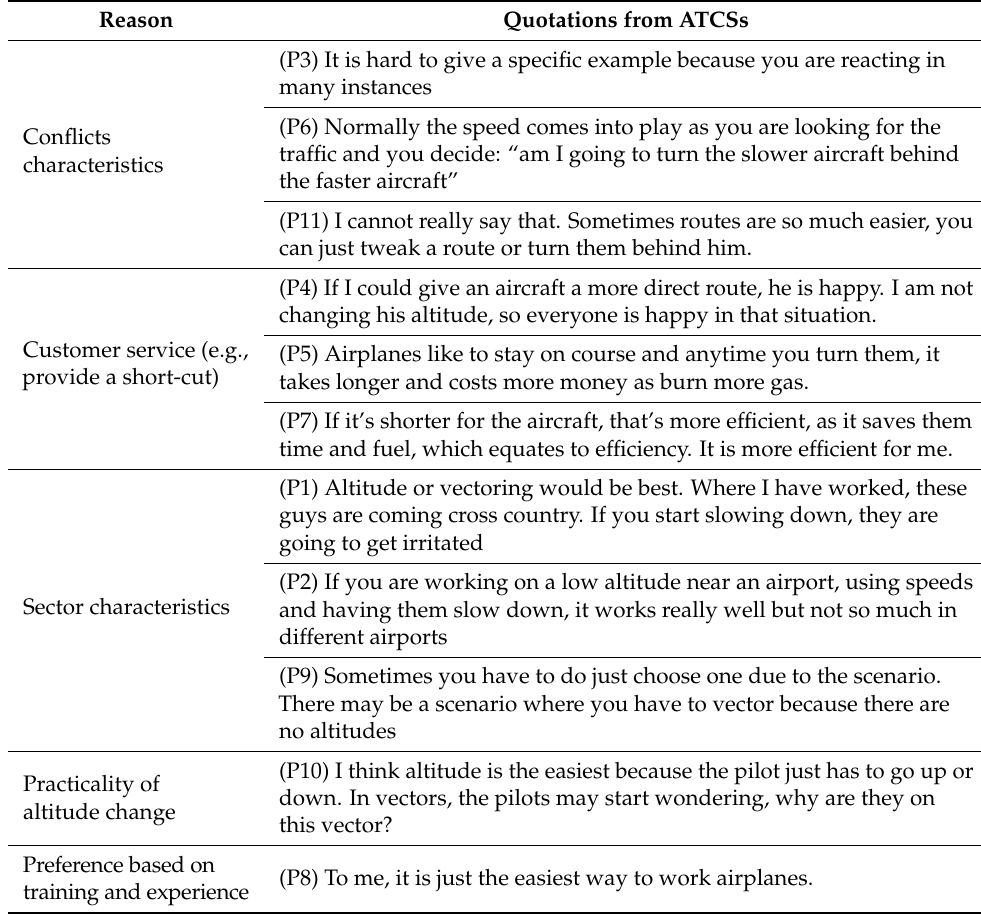
Table 12. ATCSs quotations on reason for their preferred conflict mitigation